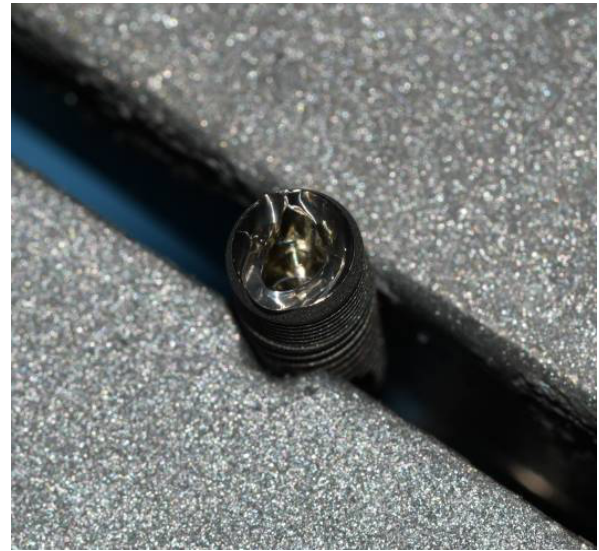
Figure 3. GapSeal gel applied on the implant.